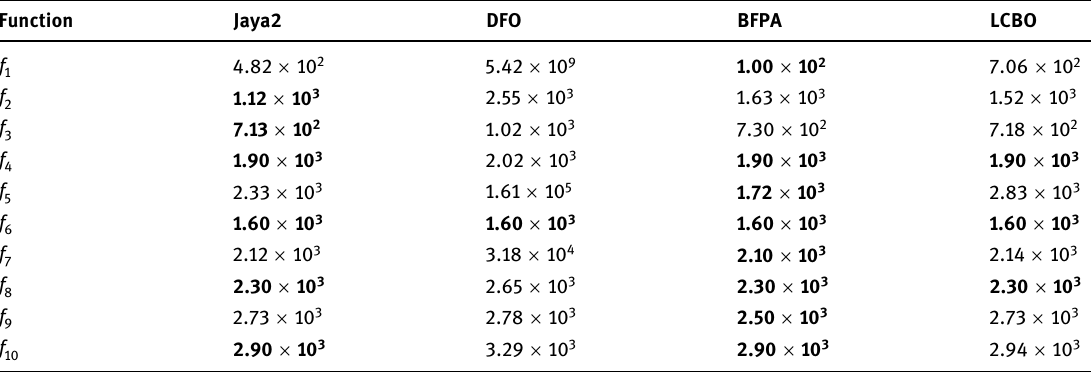
The boldface indicates the lowest median function value per function.